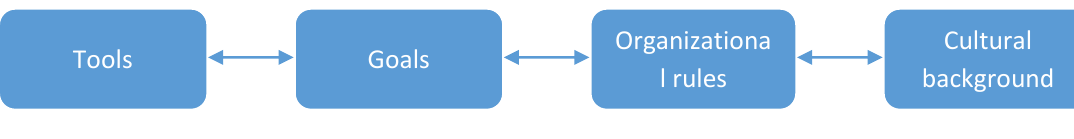
Figure 2. Results of regression within IRC